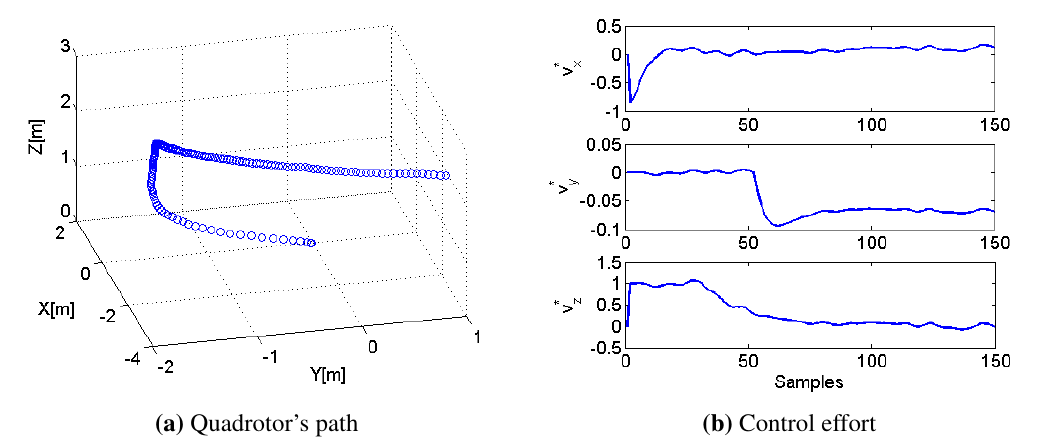
Figure 16. Performance of the path-following controller. ( a ) Quadrotor’s path around the container in order to take two pictures and ( b ) control effort required by the MPC